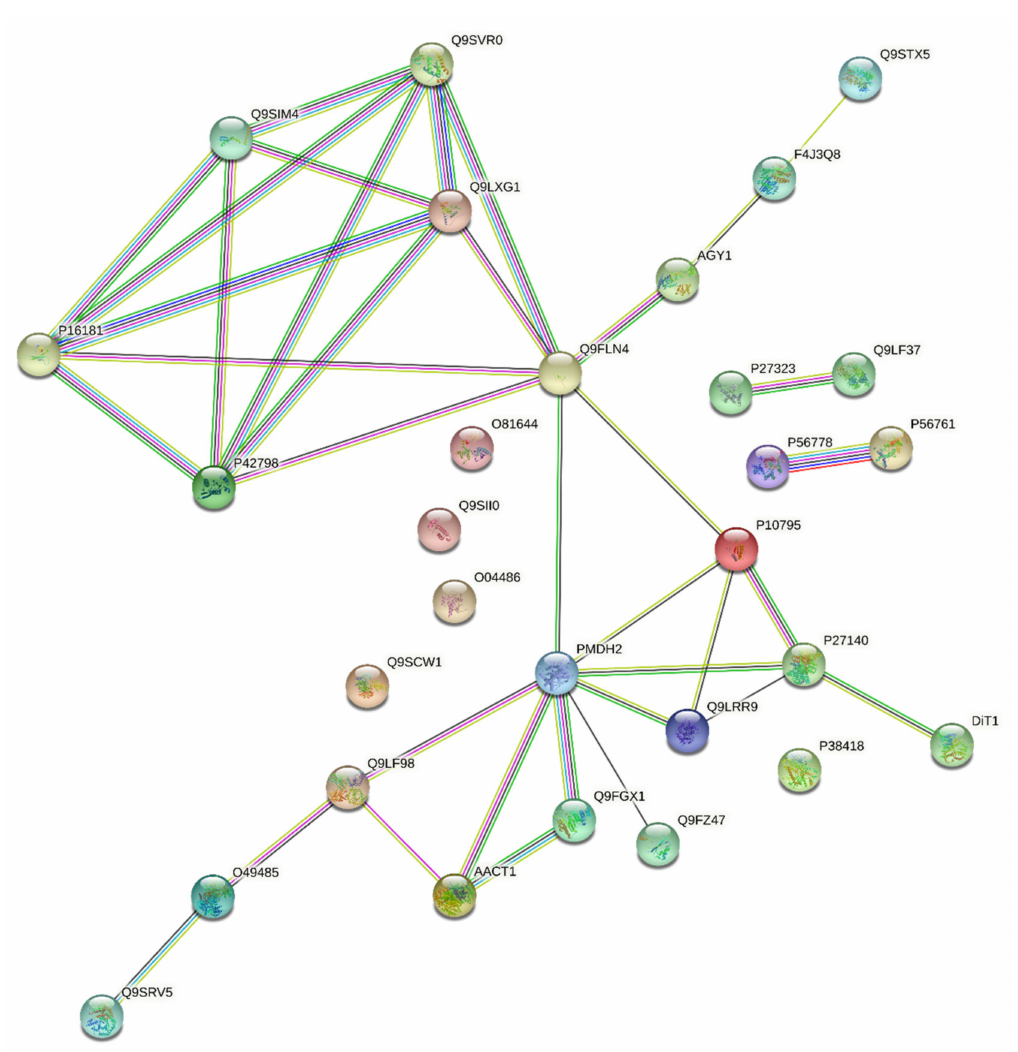
Figure 6. PPI network of the S-R3 protein set. Coloured network nodes represent proteins and edges represent protein–protein associations. In this scheme, twenty-four proteins are connected by 36 edges and 16 proteins have more than two